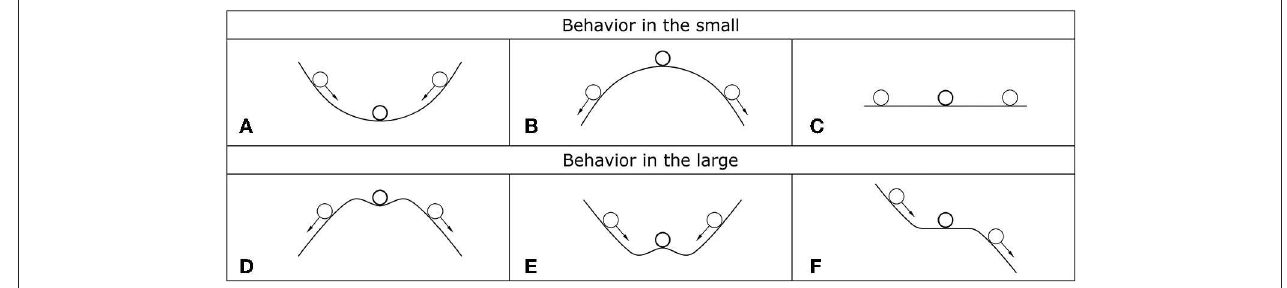
FIGURE 1 | Simple illustrative representation of stable, unstable, and indifferent equilibrium positions in the small (A–C) and in the large (D–F) . The arrows represent admissible